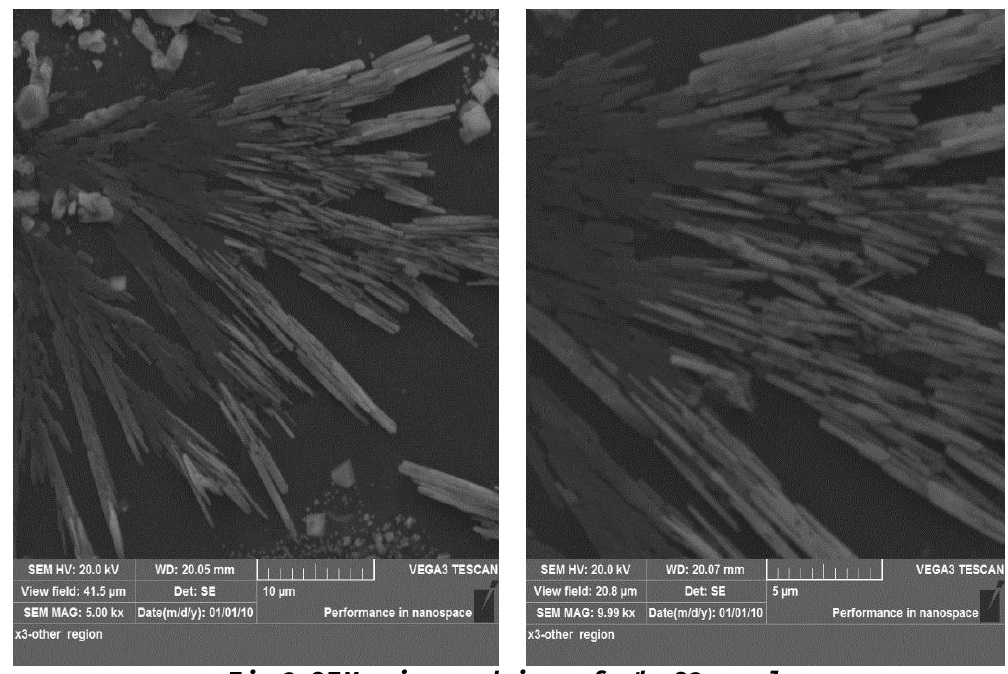
Fig. 6: SEM micrograph image for the S3 sample.